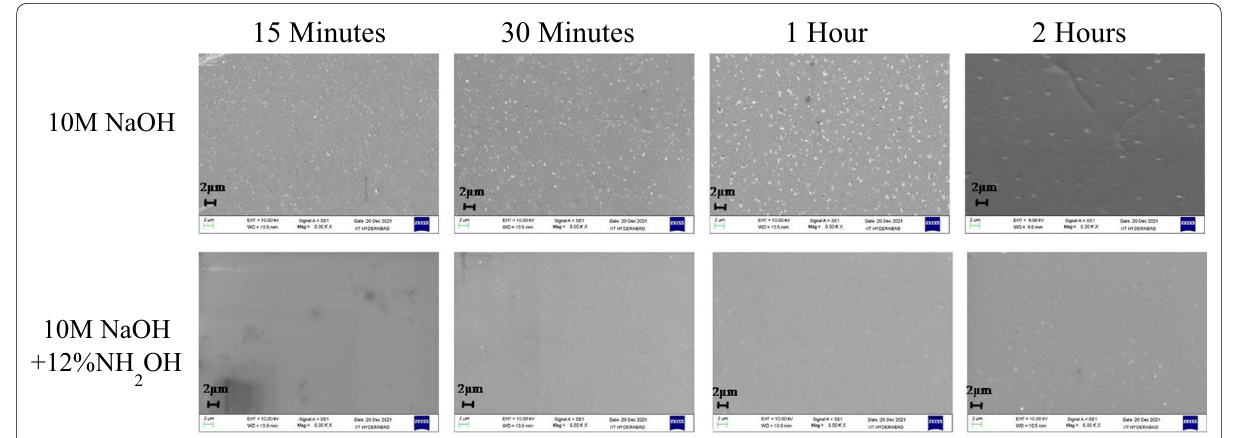
Fig. 8 SEM images of etched surface morphology of silicon {100}